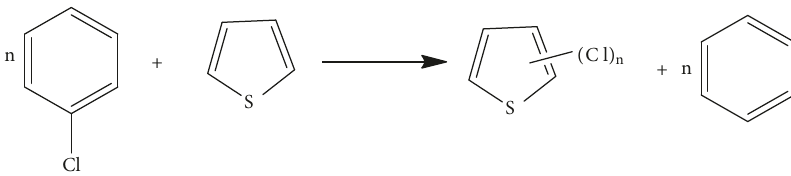
Scheme 2: Hypothetical reaction between thiophene and